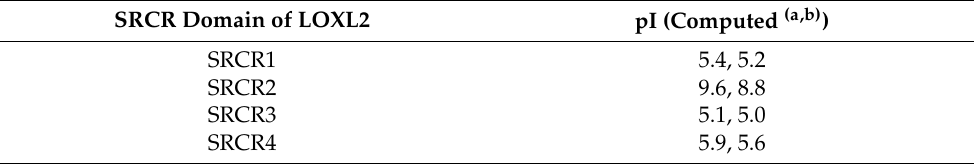
Table 3. Isoelectric points (pIs) of SRCR domains of